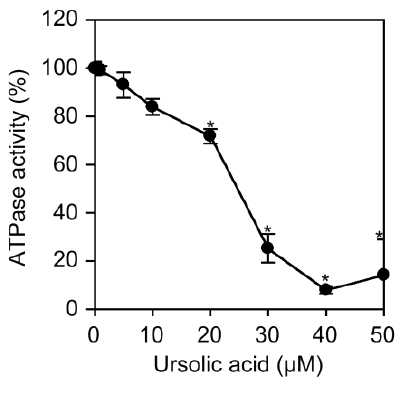
Figure 8. Ursolic acid inhibits Na + /K + -ATPase activity. Na + /K + -ATPase highly purified from porcine kidney was preincubated with various concentrations of ursolic acid for 15 min and then incubated with ATP for 30 min in the presence of ursolic acid. The inorganic phosphates produced by ATP hydrolysis were measured. Data points represent means ± SD (n = 3). * P < 0.01, compared with